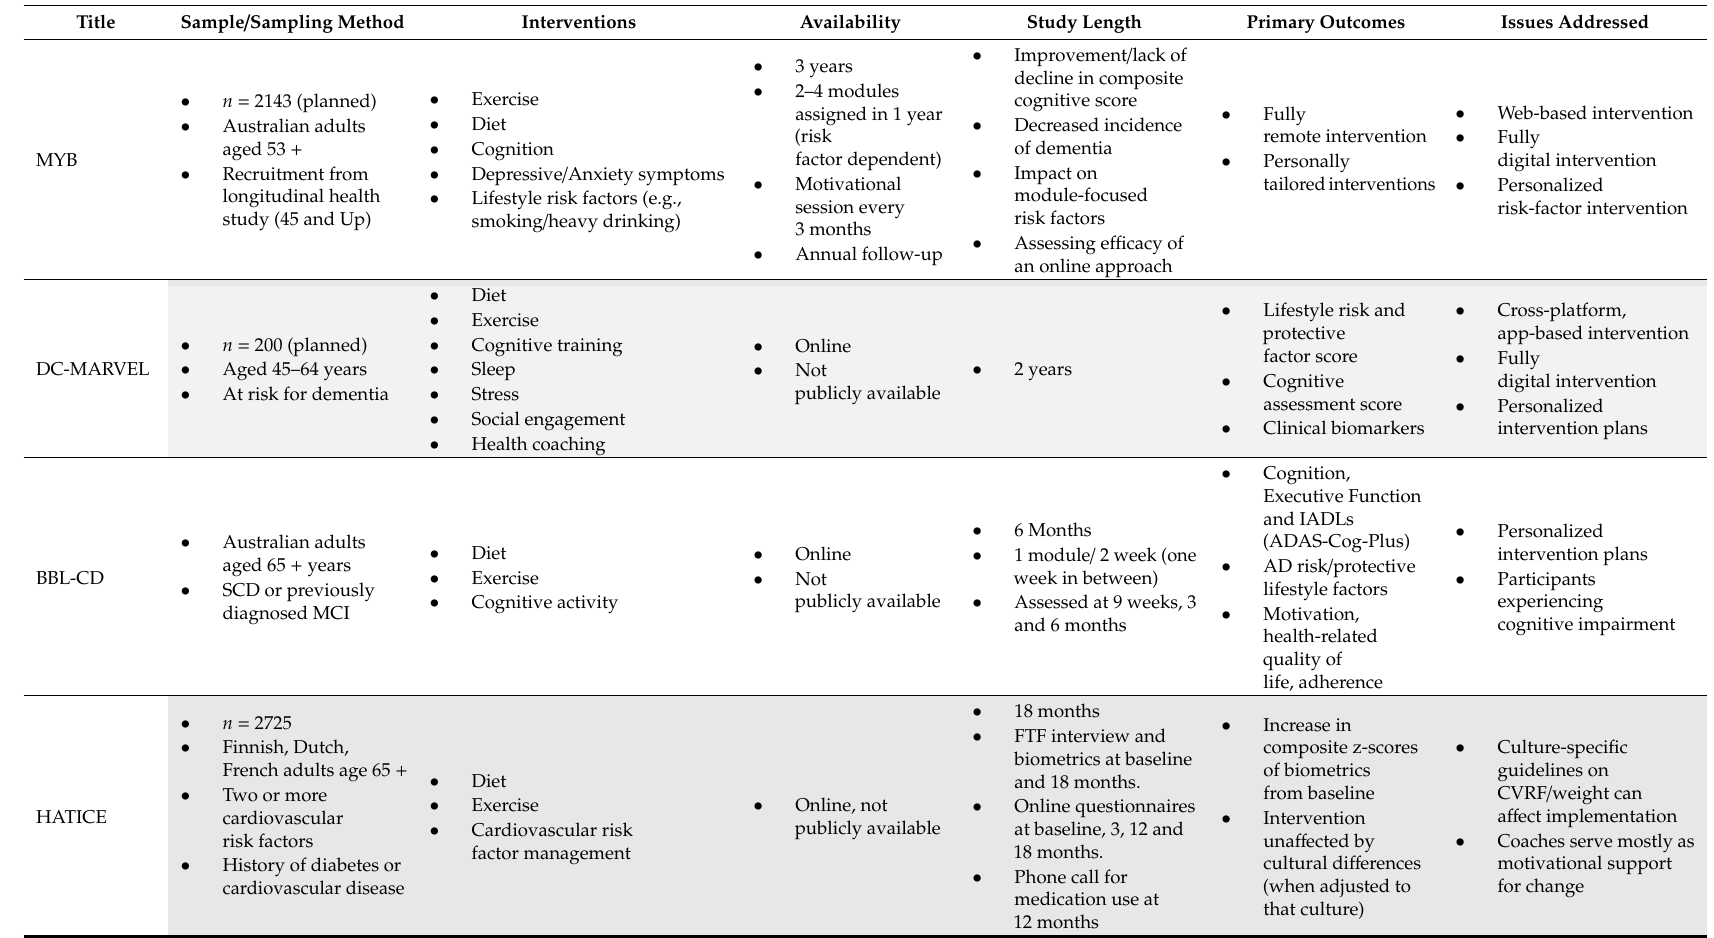
Table 4. On-going or prospective digital multidomain interventions to enhance cognitive reserve and reduce risk of